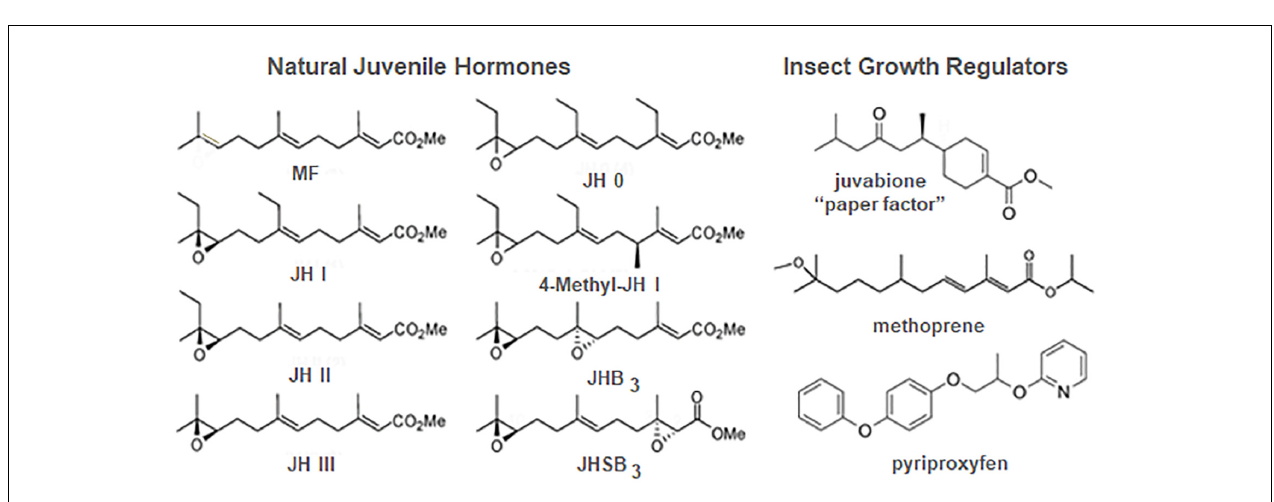
FIGURE 5 | Structures of the natural juvenile hormones (JH) (left) and some JH analogs known as insect growth regulators (IGRs) (right) . JHB 3 , JH bisepoxide;